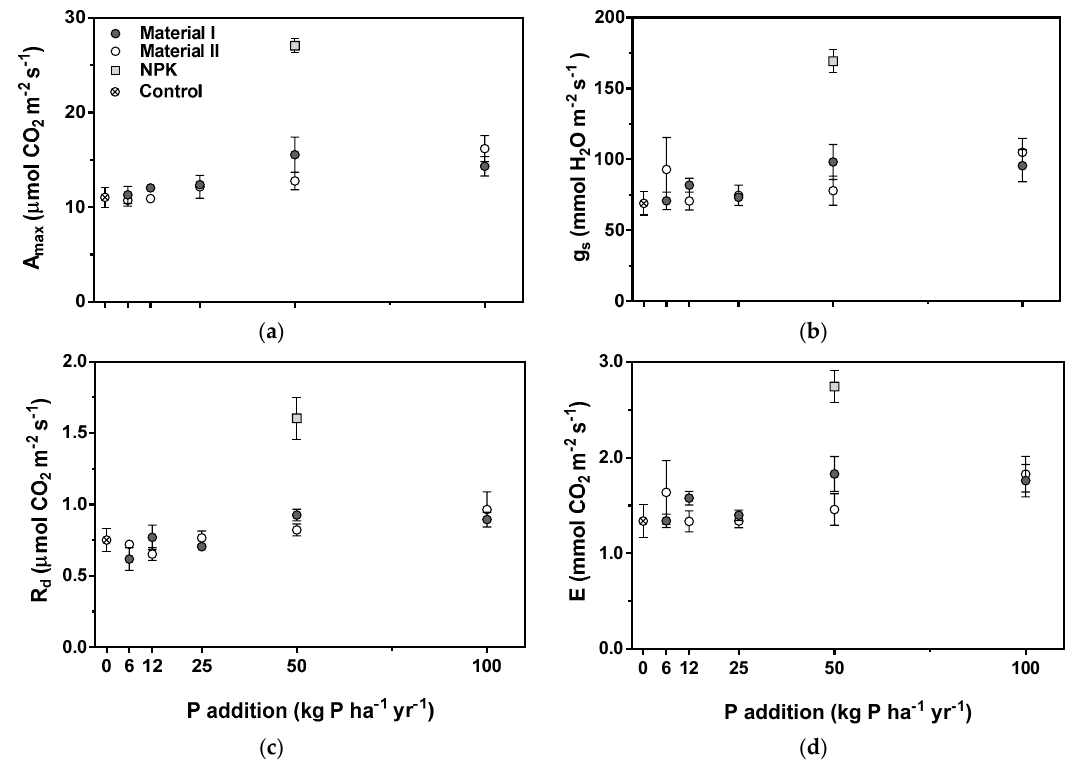
Figure 2. Effects of increasing phosphorus (P) supply when added as P-enriched material (I or II) with five P levels (6, 12, 25, 50, 100 kg P ha − 1 yr − 1 ) on Zea mays ( a ) photosynthetic rate (A max ; µmol CO 2 m − 2 s − 1 ), ( b ) stomatal conductance (g s ; mol H 2 O m − 2 s − 1 ), ( c ) dark respiration (R d ; µmol CO 2 m − 2 s − 1 ), and ( d ) transpiration (E; mol CO 2 m − 2 s − 1 ). The control treatment